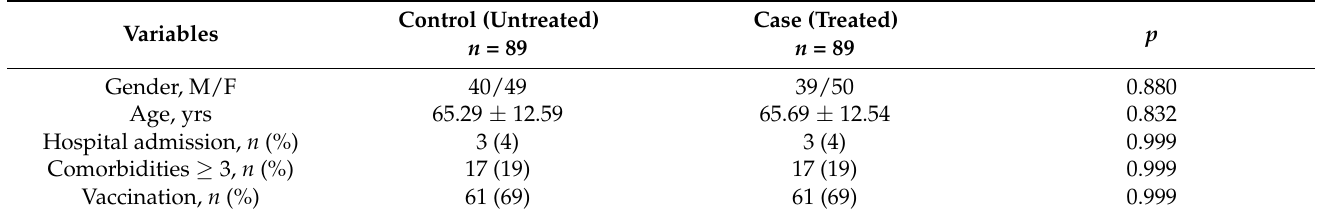
Table 3. Demographic and clinical characteristics of the propensity-score-matched case – control groups according to the administration of early therapy (untreated vs. treated).